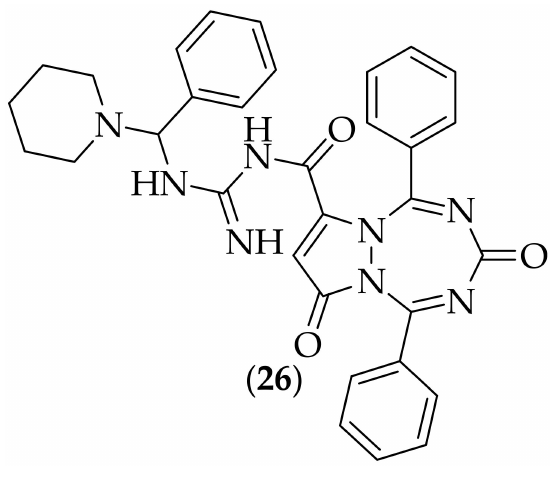
Figure 15. Mannich base antifungal derivative ( 26 ).